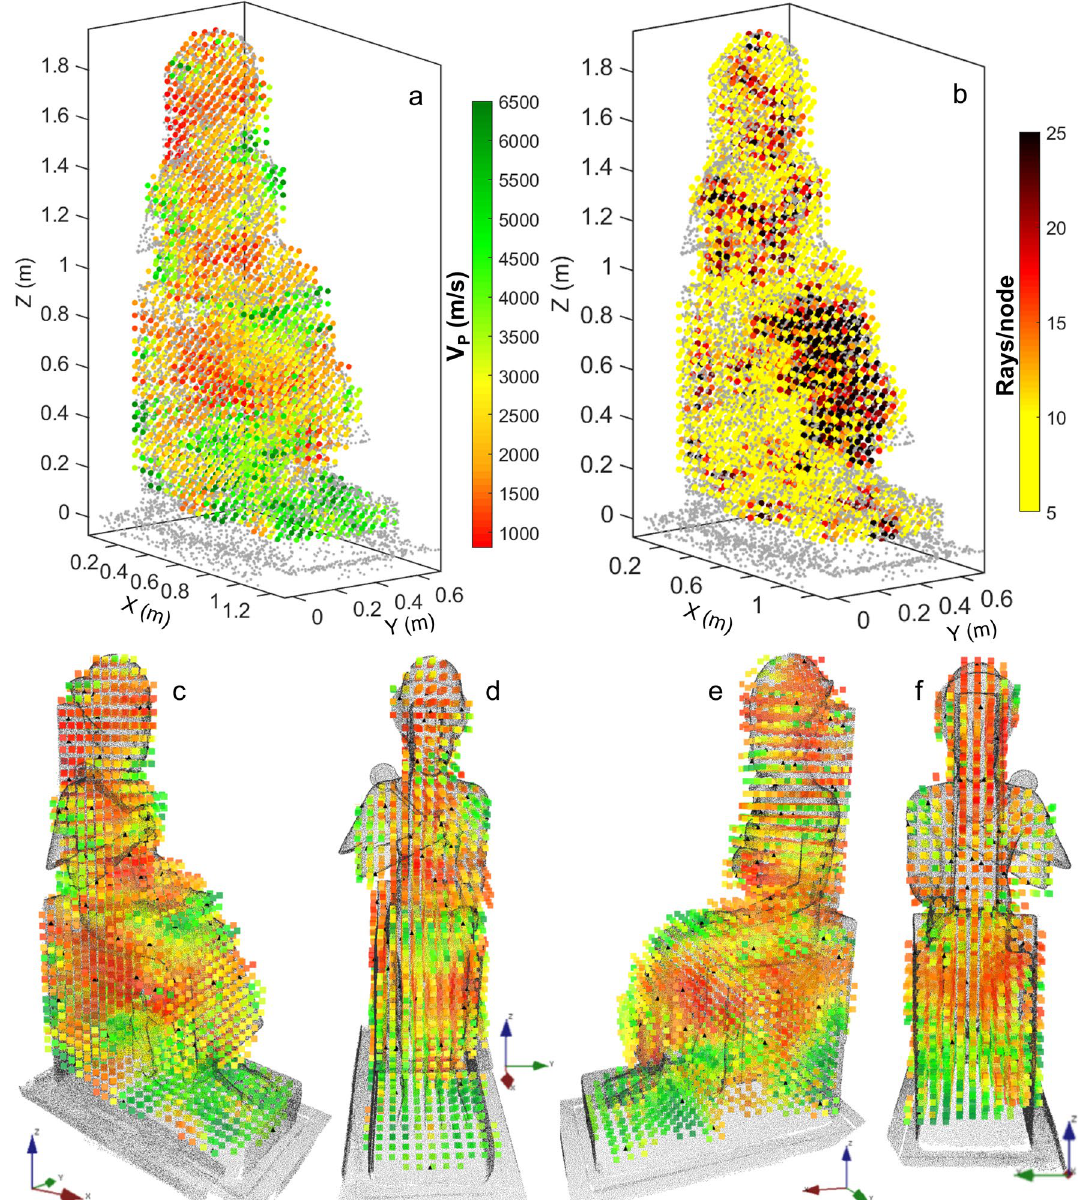
Figure 6. Results of the 3D ultrasonic tomography inversion. ( a ) Final velocity model and ( b ) ray coverage visualized in the simplified point cloud of the statue (Matlab R2021b, https:// it. mathw orks. com/ produ cts/ matlab. html). ( c – f ) Final velocity model from different views: ( c ) right frontal side, ( d ) front, ( e ) left frontal side, ( f ) back (point cloud rendering in Voxler, Demo version 4.6.913, https:// www. golde nsoft ware. com/ produ cts/